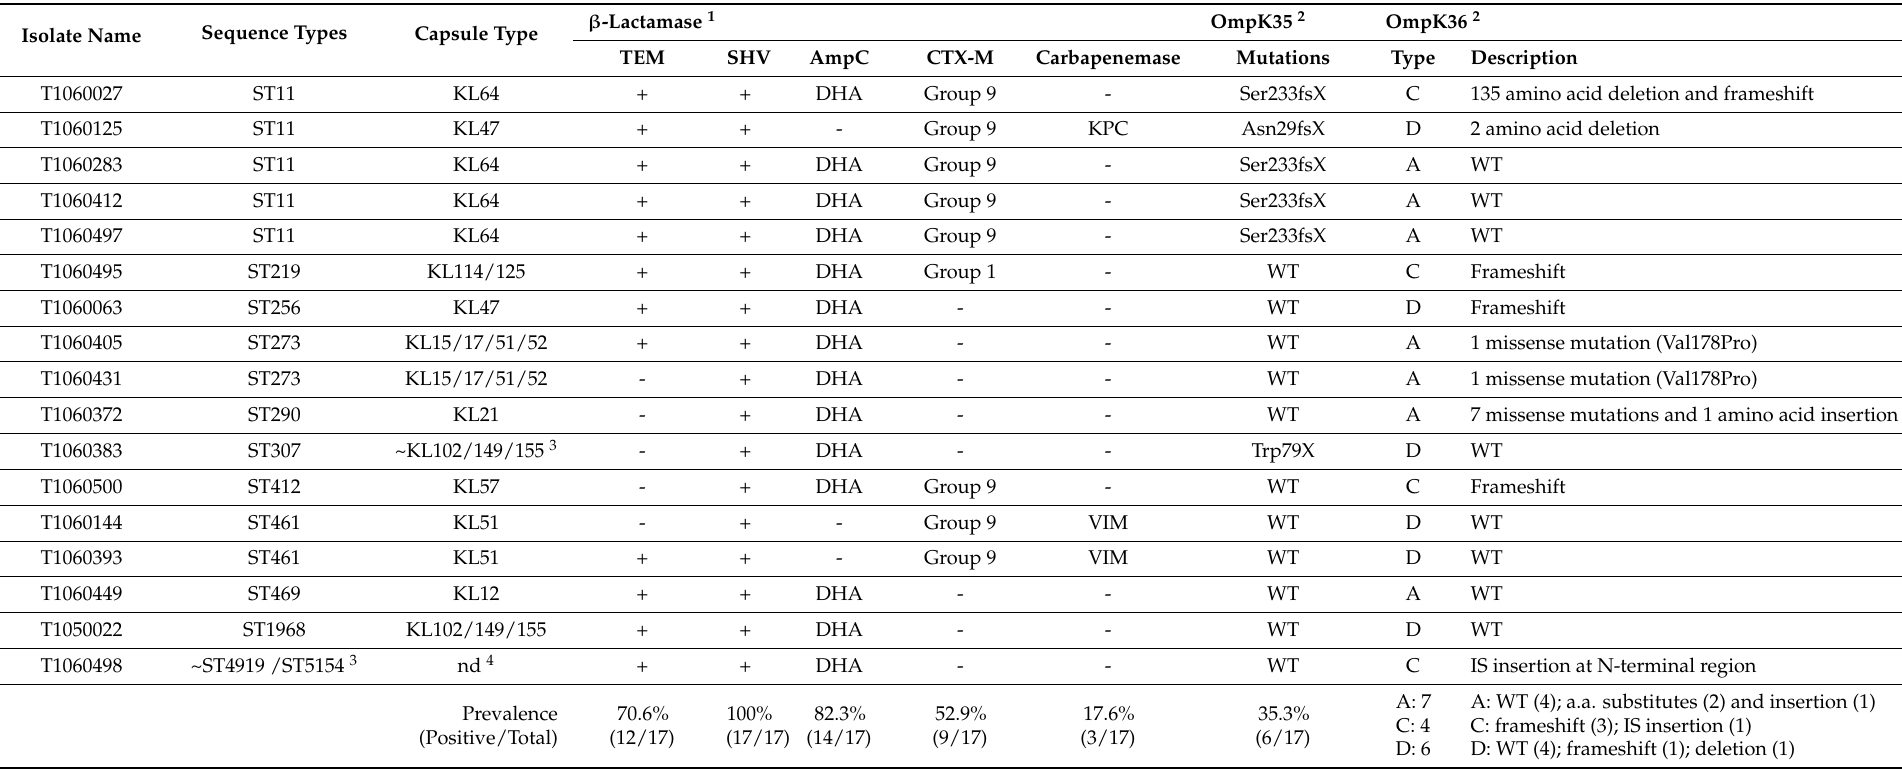
Table 2. Molecular characterization of 17 carbapenem-resistant K. pneumoniae isolates from urine at Taipei Medical University